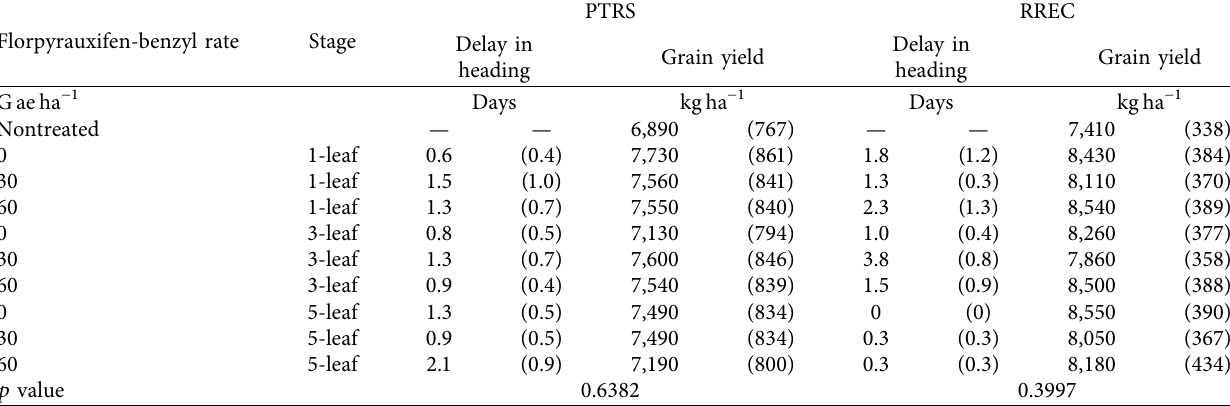
Table 3: Heading and grain yield response of CL111 at the Pine Tree Research Station (PTRS) and Rice Research and Extension Center (RREC) a,b,c . Florpyrauxifen-benzyl rate Stage